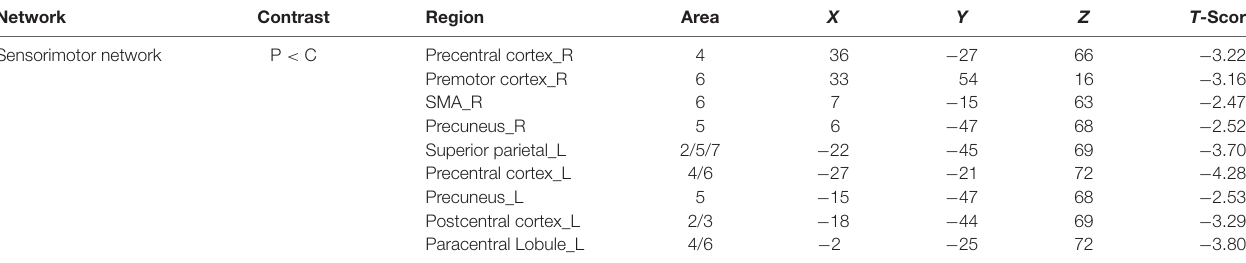
TABLE 2 | Local maxima of regions with altered connectivity within the sensorimotor network (SMN). Network Contrast Region Area Sensorimotor network P < C